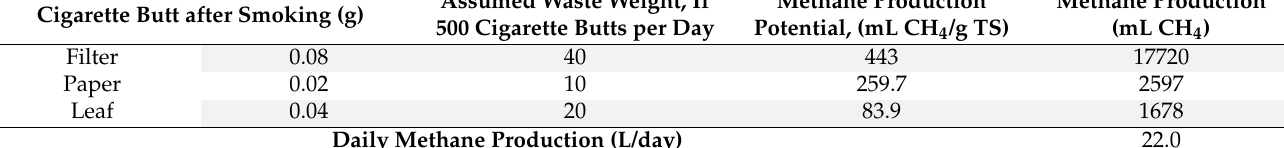
Table 4. Energy calculation estimated from methane production from cigarette butts leftover in a smoking room. Cigarette Butt after Smoking (g) Filter